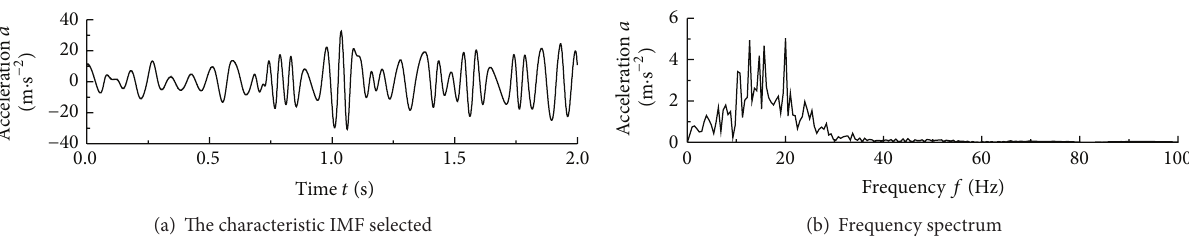
Figure 18: Analysis results of the signal presented in Figure 16 by EEMD: (a) the characteristic IMF and (b) FFT spectrum.